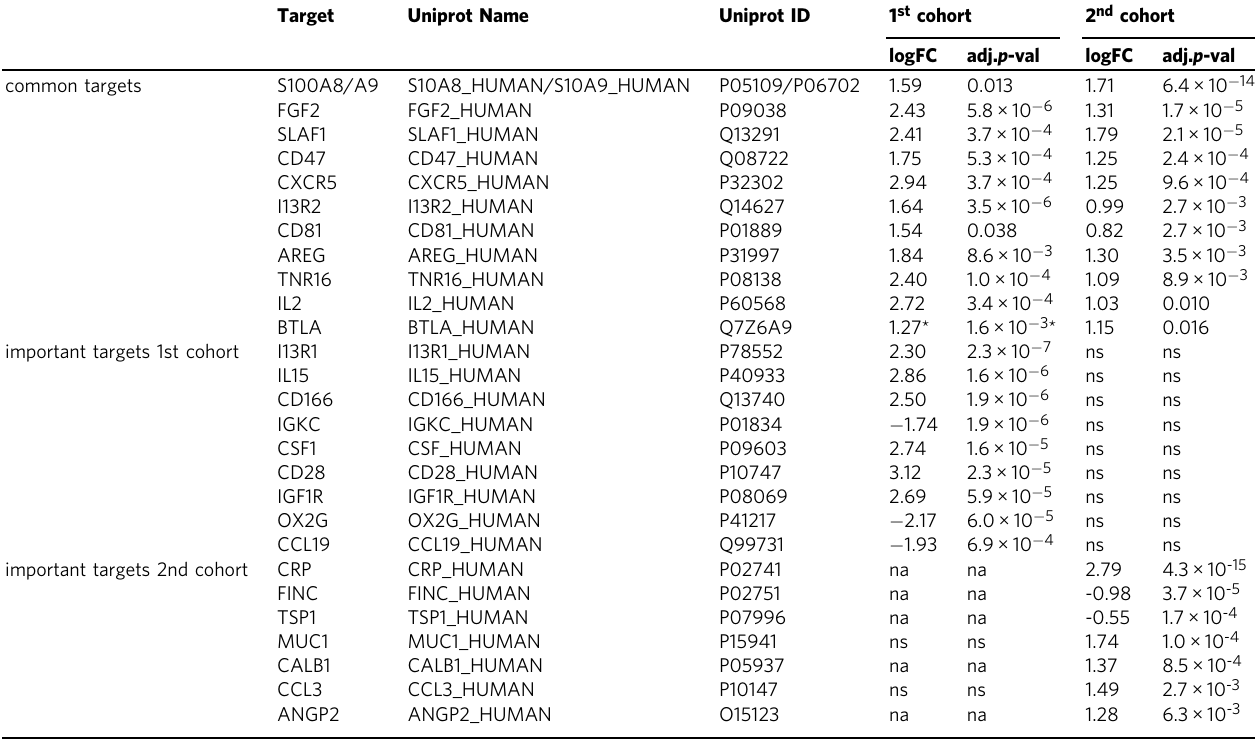
Table 2 Most important identi fi ed biomarkers within at least one of both